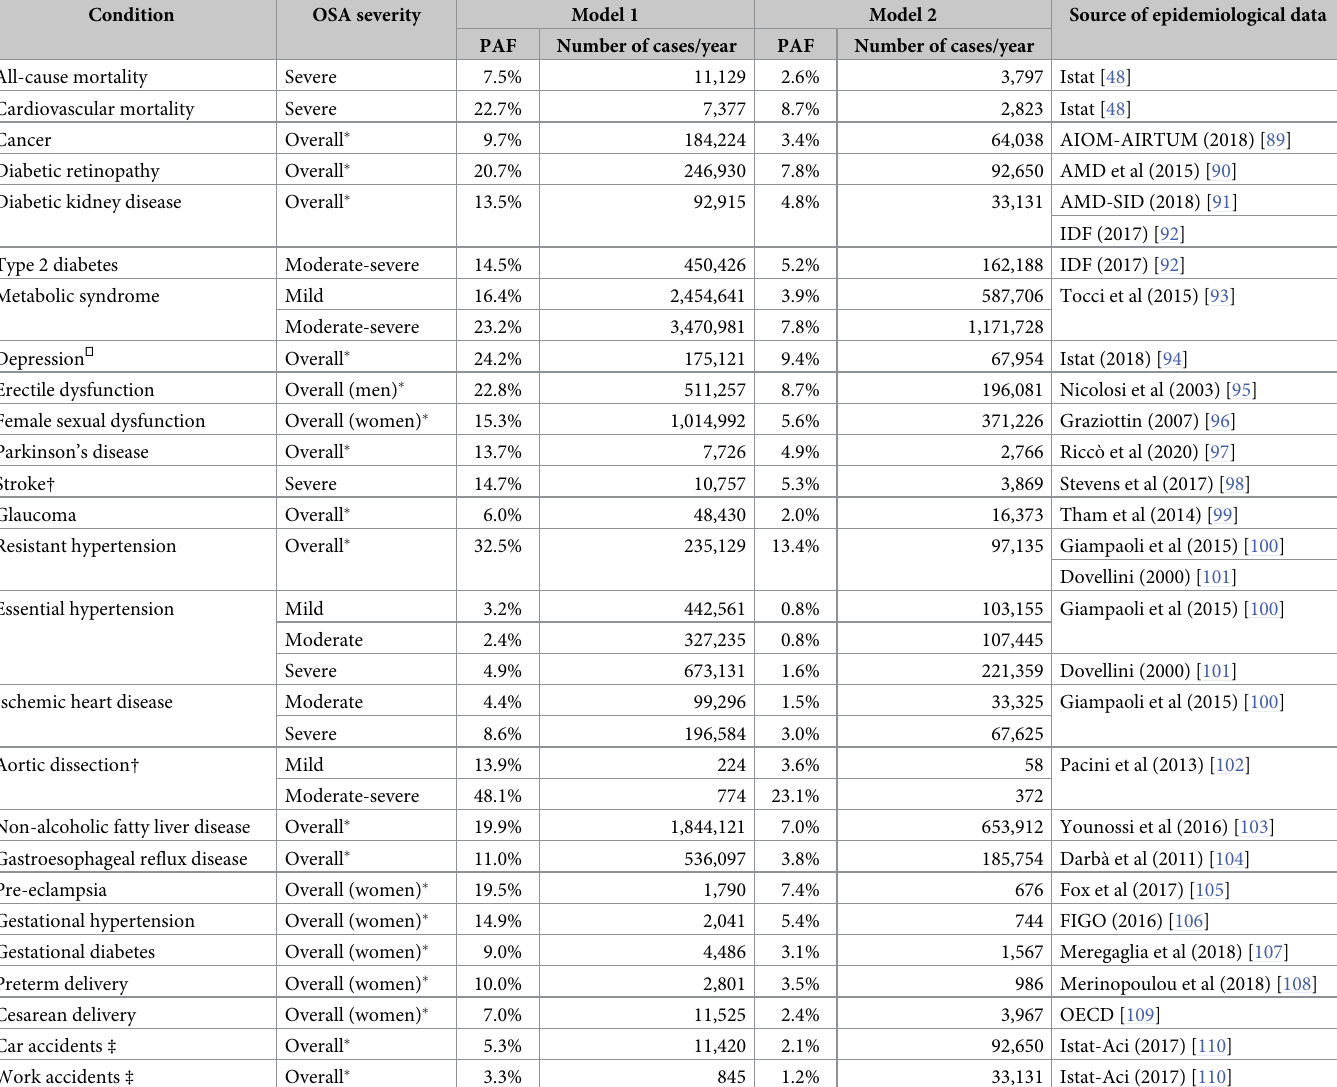
Table 3. Conditions’ burden influenced by OSA: PAF and number of cases/year among general adult population in Italy (aged 15–74 years).